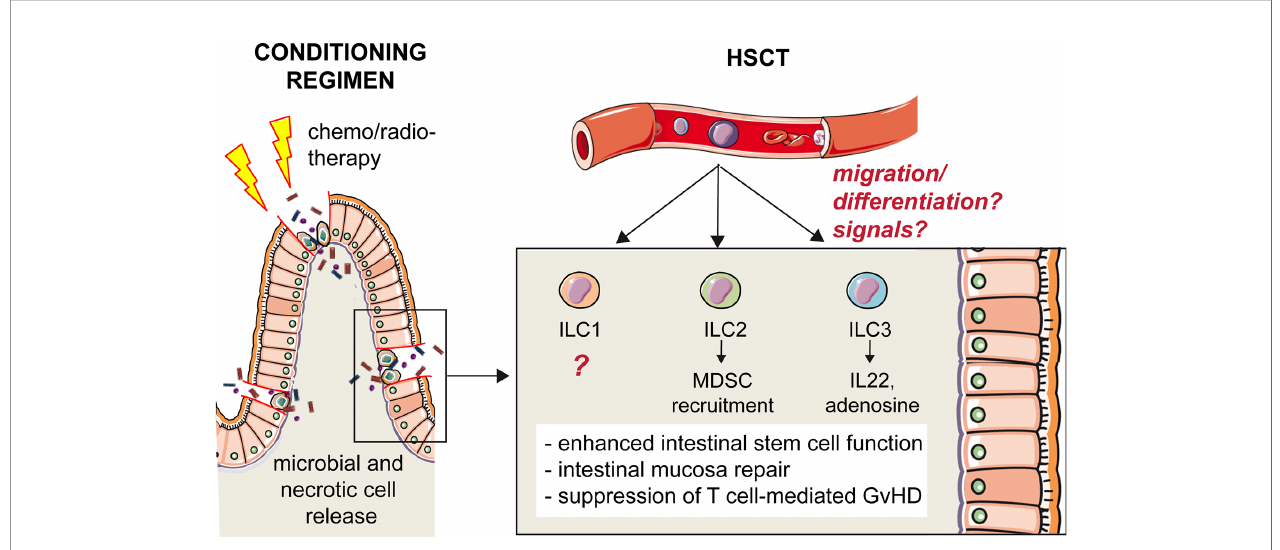
FIGURE 2 | Protective role of hILCs from intestinal GvHD. High-dose preparative regimens that precede HSCT compromise the barrier function of intestinal epithelium and induce the release of microbial and necrotic-cell elements into adjacent tissues and in the bloodstream. The disruption of the intestinal mucosal barrier increases the incidence and severity of GvHD after HSCT. Helper ILCs play a protective role, although it is still not clear what are the signals that trigger these cells and what is their origin. One hypothesis is that a common ILC precursor is recruited from the peripheral blood to the in fl amed tissue, and that differentiation occurs locally in response to environmental signals. The role of ILC1s in intestinal GvHD is unknown. ILC2s recruit MDSC that, in turn, suppress T cell-mediated GvHD. ILC3s secrete IL-22 enhancing intestinal stem cell function and promoting repair, and release adenosine, suppressing T cell